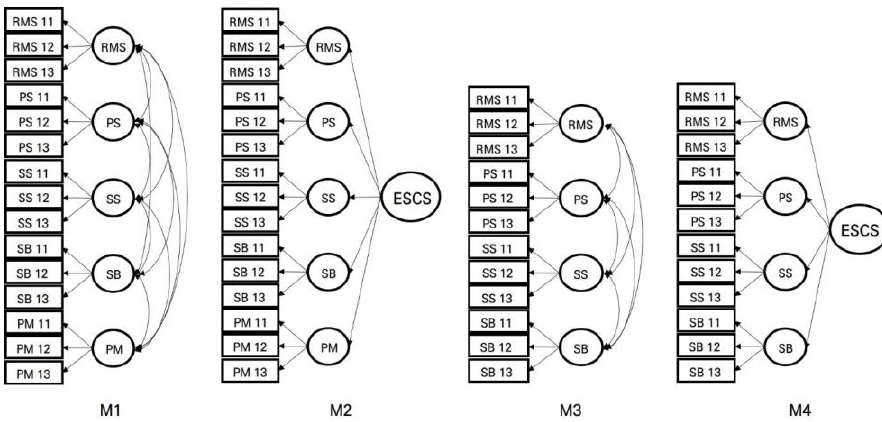
Figure 1. Proposed models illustrate the numbers of factors and orders. M1 is first- order five factors, M2 is second-order five factors, M3 is first-order four factors, and M4 is second-order four